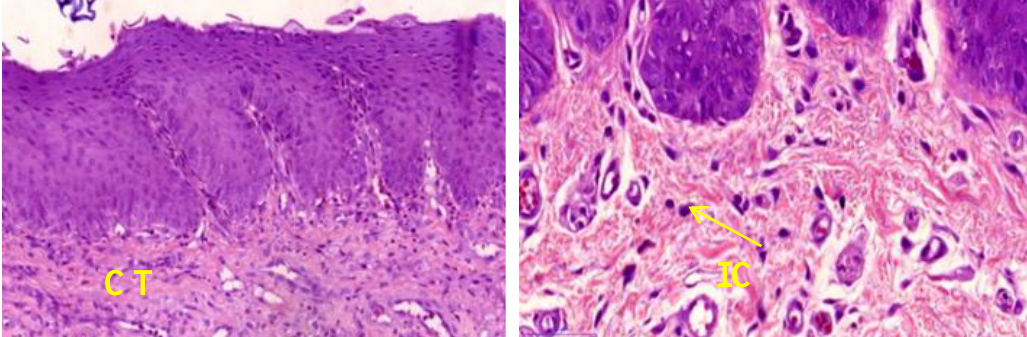
Figure 8: Microphotograph of study group treated with gingival sulcular irrigation of 50 μL/kg of 5% green tea extract after seven days showing fibrous connective tissue (CT), scarce number of inflammatory cells (IC) (arrow) and complete epithelization. . H&E x20, x40.